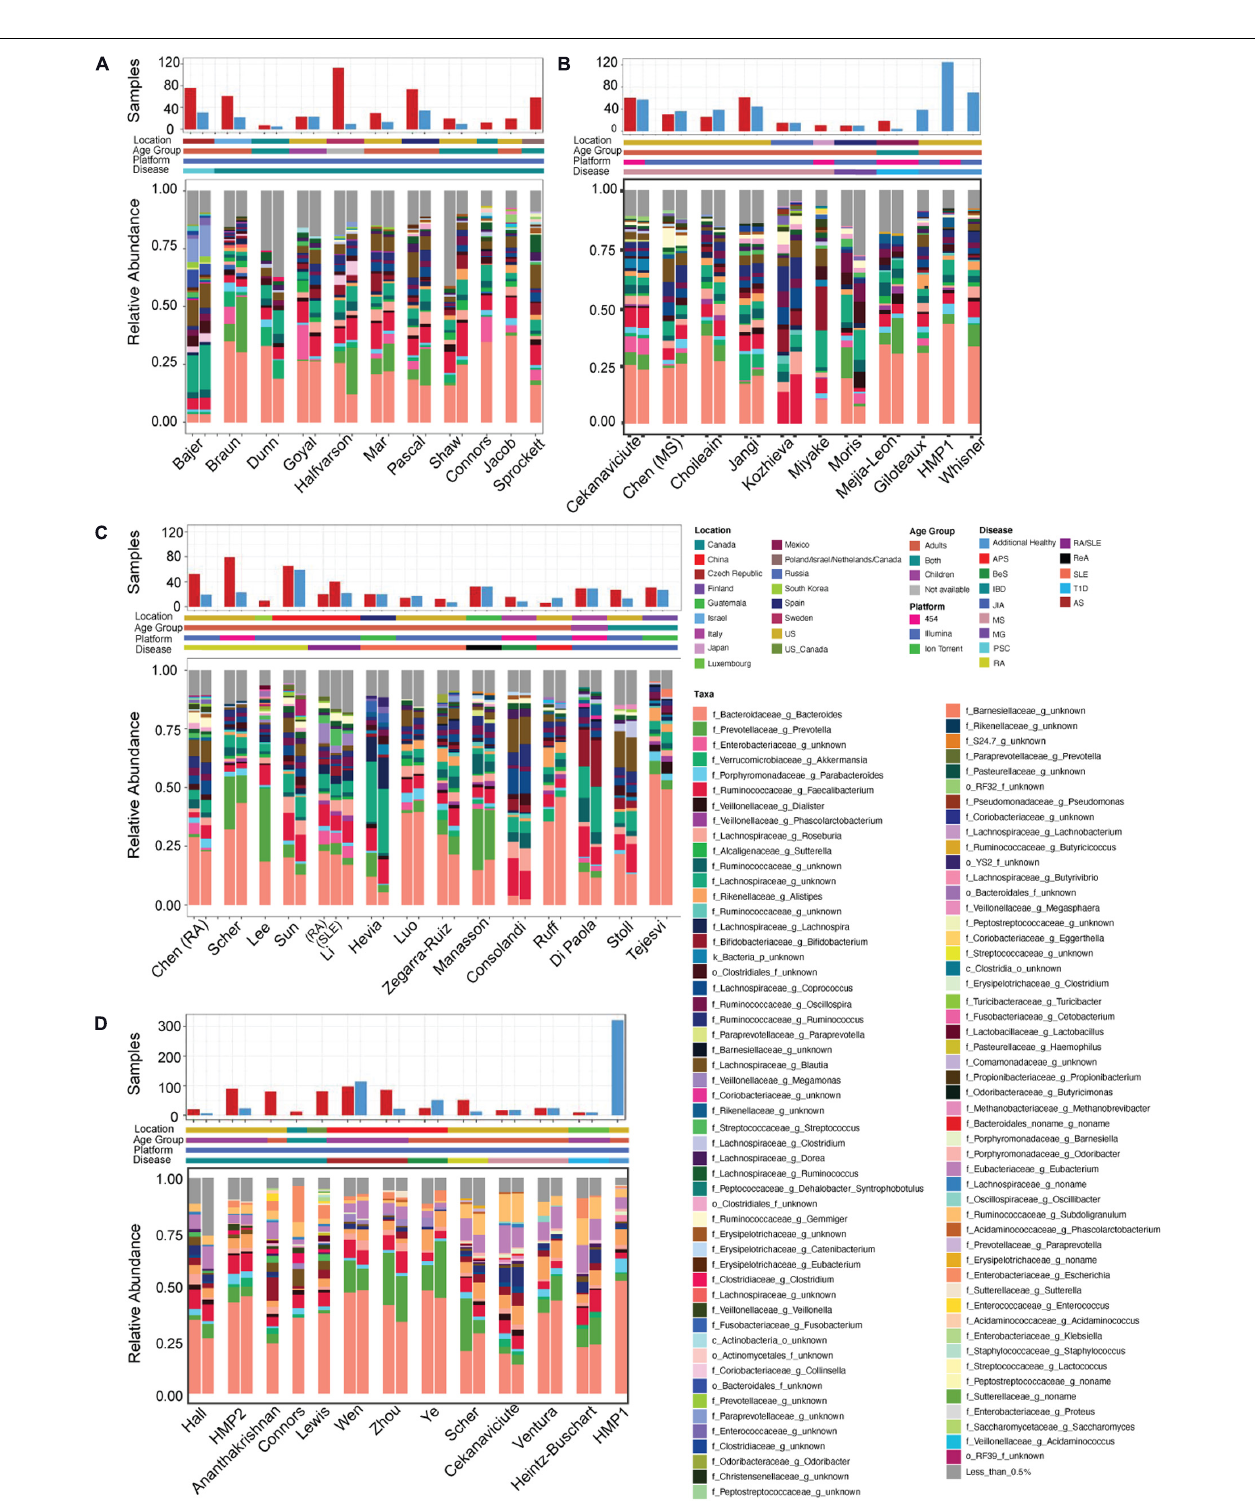
FIGURE 2 | Study overview. Overview of (A–C) 16S rRNA sequencing and (D) shotgun metagenomics studies included in our analysis. Includes the number of healthy (blue bars) and disease (red bars) samples in each, geographic location, age group and disease studied. Also includes the average relative abundance of taxa at the genus level for the healthy and diseased subjects following re-processing. Inflammatory bowel disease (IBD), multiple sclerosis (MS), rheumatoid arthritis (RA), juvenile idiopathic arthritis (JIA), systemic lupus erythematosus (SLE), type 1 diabetes (T1D), primary sclerosing cholangitis (PSC), Behcet’s syndrome (BeS), ankylosing spondylitis (AS), antiphospholipid syndrome (APS), myasthenia gravis (MG), and reactive arthritis (ReA).